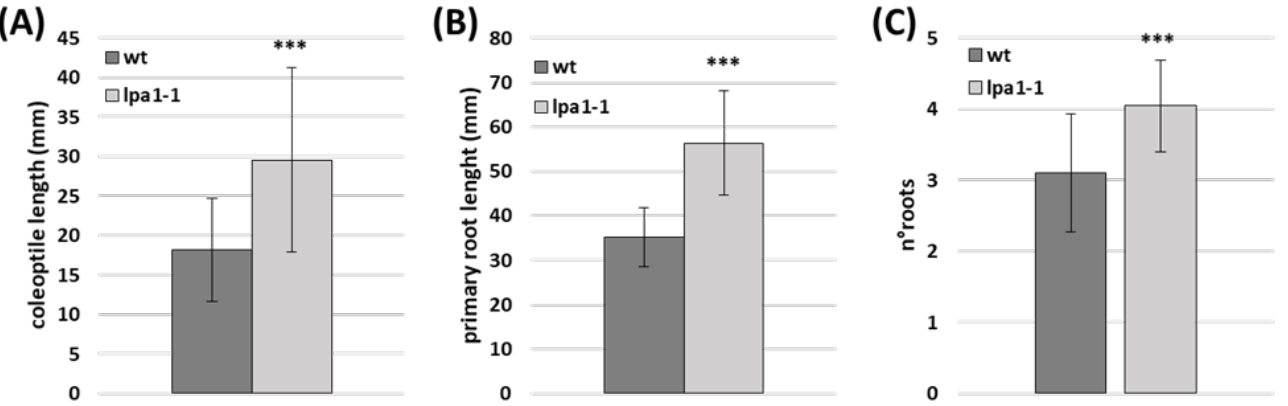
Figure 2. Coleoptile length ( A ), primary root length ( B ), and number of roots (primary and seminals) ( C ) measured at 5 DAS in controlled conditions. The data represent the mean of thirty-eight and